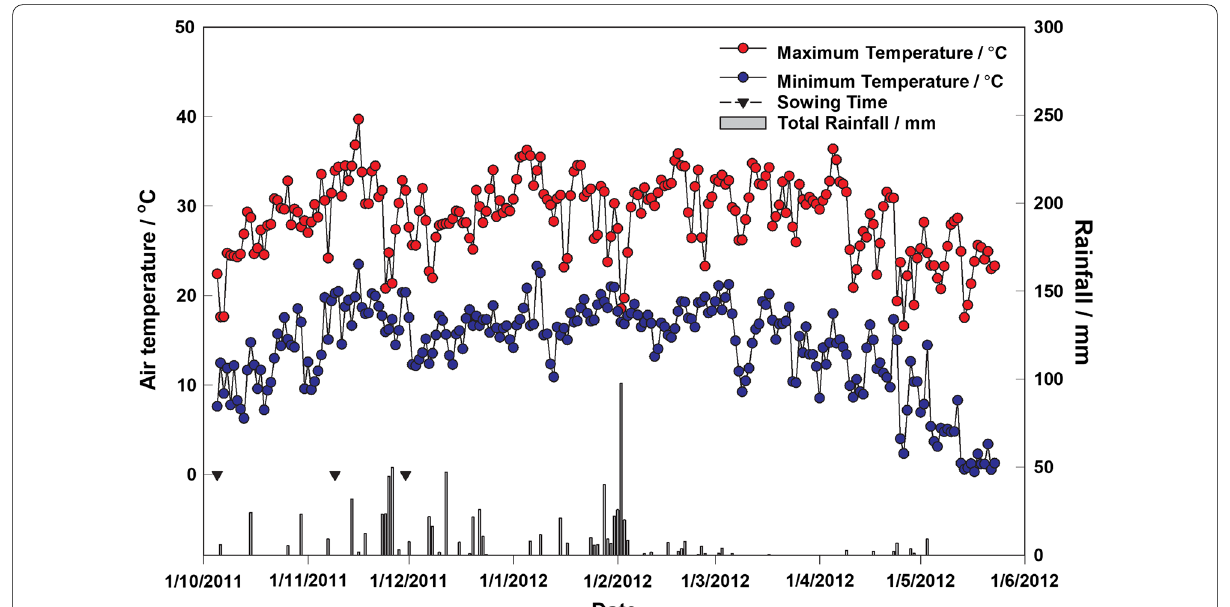
Fig. 1 Daily minimum (°C, blue) and maximum (°C, red) air temperature and rainfall (mm, grey) at ACRI, Narrabri from 5th October 2011 to 23rd May 2012, respectively. Sowing dates (triangles) were 5th October 2011 (S1), 9th November 2011 (S2) and 30th November 2011